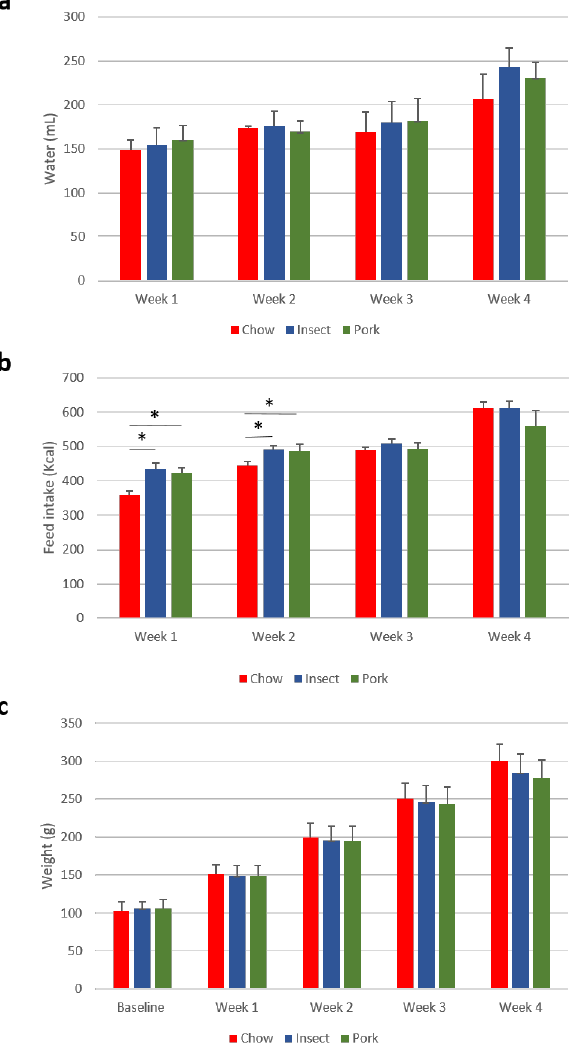
Figure 1. Water consumption, feed intake and body weight of the rats during the intervention period. ( a ) Water consumption ( b ) feed intake per week, and ( c ) the body weight of the rats was measured each week doing the intervention period. Data were analyzed by one-way ANOVA, values within the same cluster not sharing a common letter are significant different ( p < 0.05). Chow diet (Chow, n = 6, red), insect-substituted pork sausage diet (Insect, n = 12, blue or pork sausage diet (Pork, n = 12, green). The groups found to be significantly different by ANOVA ( p -value > 0.05) are marked with a star (*).